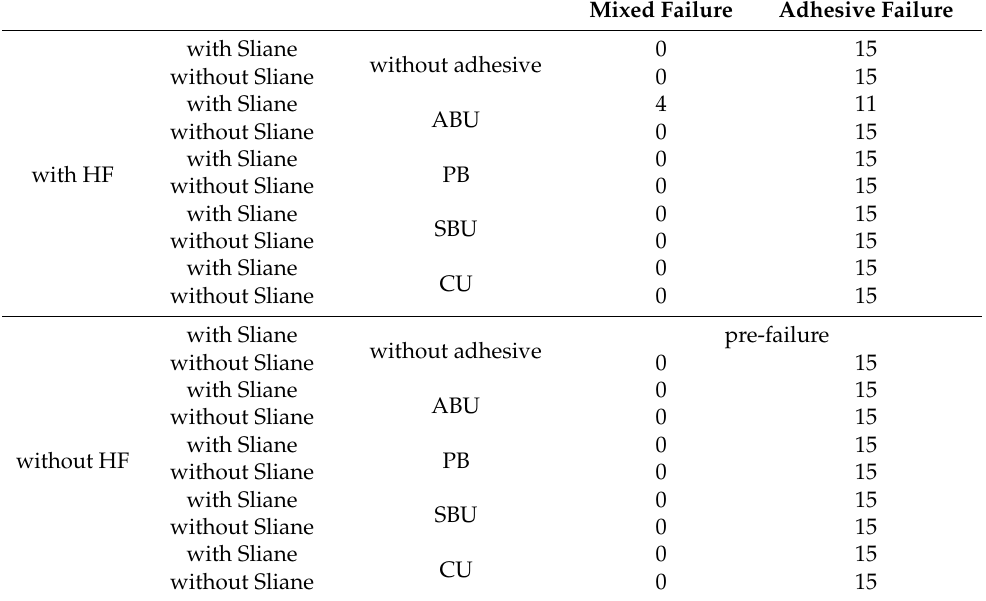
Table 3. Failure mode